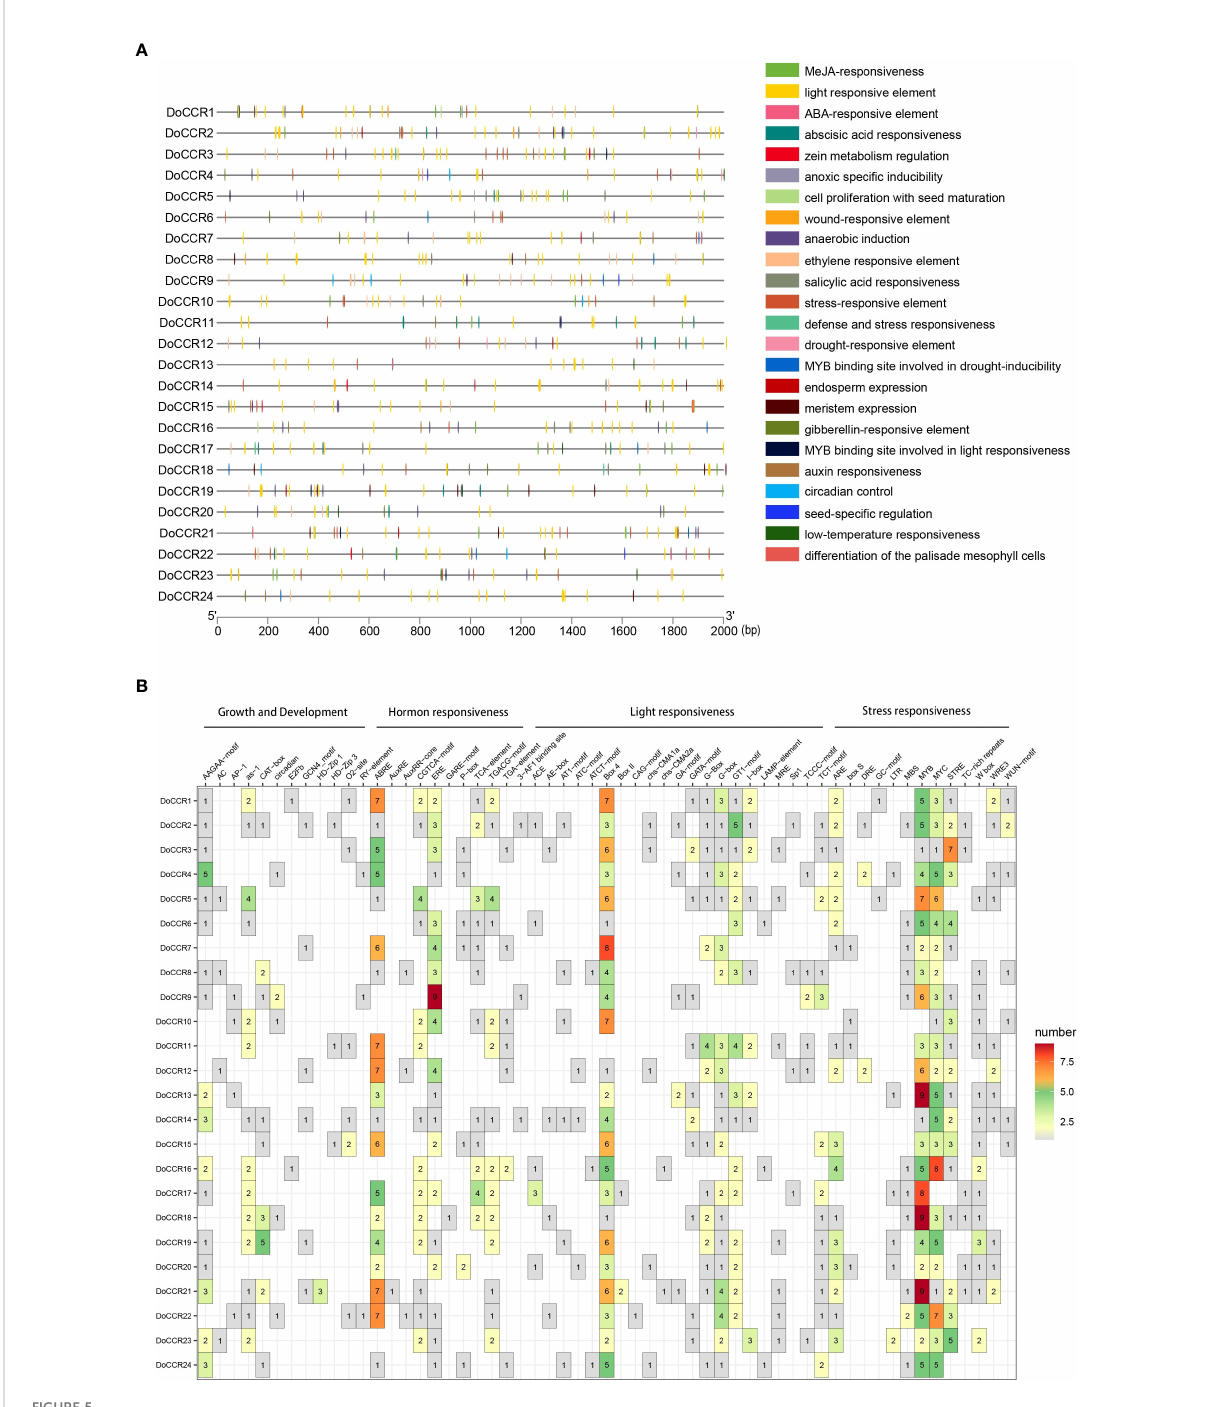
FIGURE 5 Representation of cis-acting elements in the promoter regions of DoCCR genes. (A) Distribution of different kinds of cis-elements in the upstream 2,000 bp sequences of the DoCCRs . Different color boxes correspond to the identity of cis-elements; some cis-elements may overlap with others. (B) The number of cis-elements in the promoters of the DoCCRs